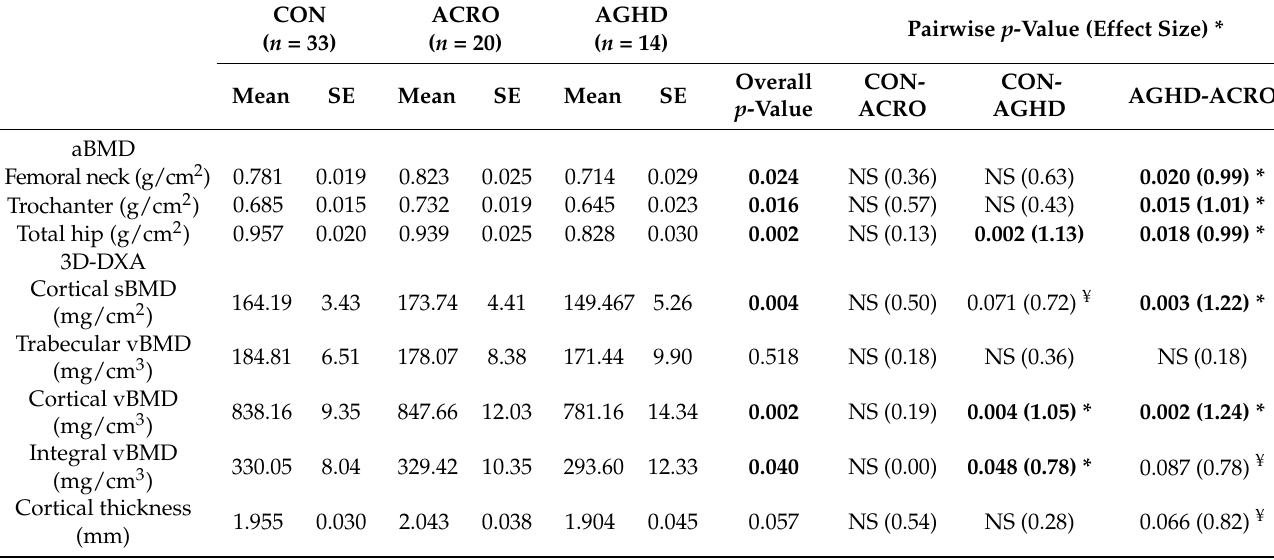
Table 2. Differences (adjusted by age, sex and body mass index) in the areal bone mineral density (aBMD) and 3D-DXA parameters between the study